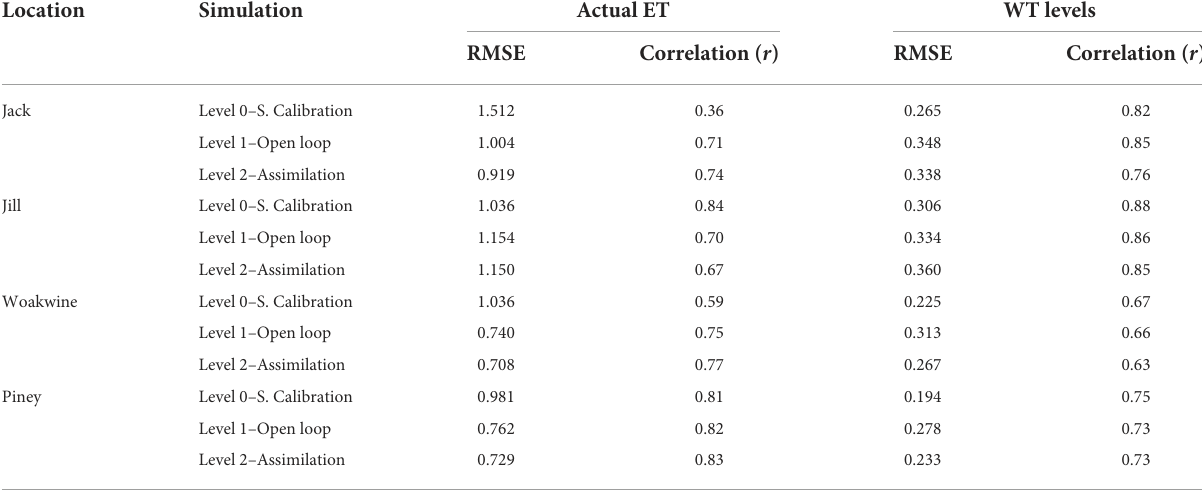
TABLE 3 RMSE and r calculated on actual ET and WT levels.